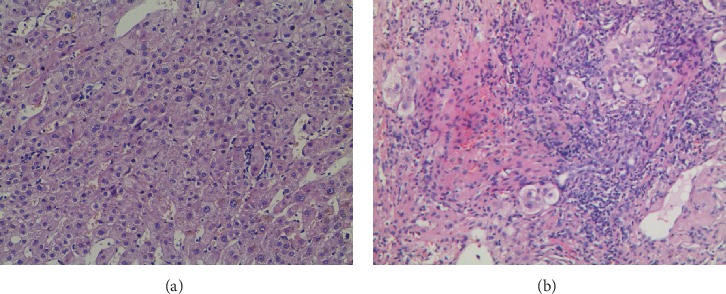
Typical liver biopsy from patients with or without lymph node enlargement. (a) In patients with lymph node enlargement, leukomonocyte infiltrates and focal necrosis are present. (b) In patients with lymph node enlargement, interface hepatitis, leukomonocyte infiltrates, cholestasis, focal necrosis, and hepatic rosette formation are present.